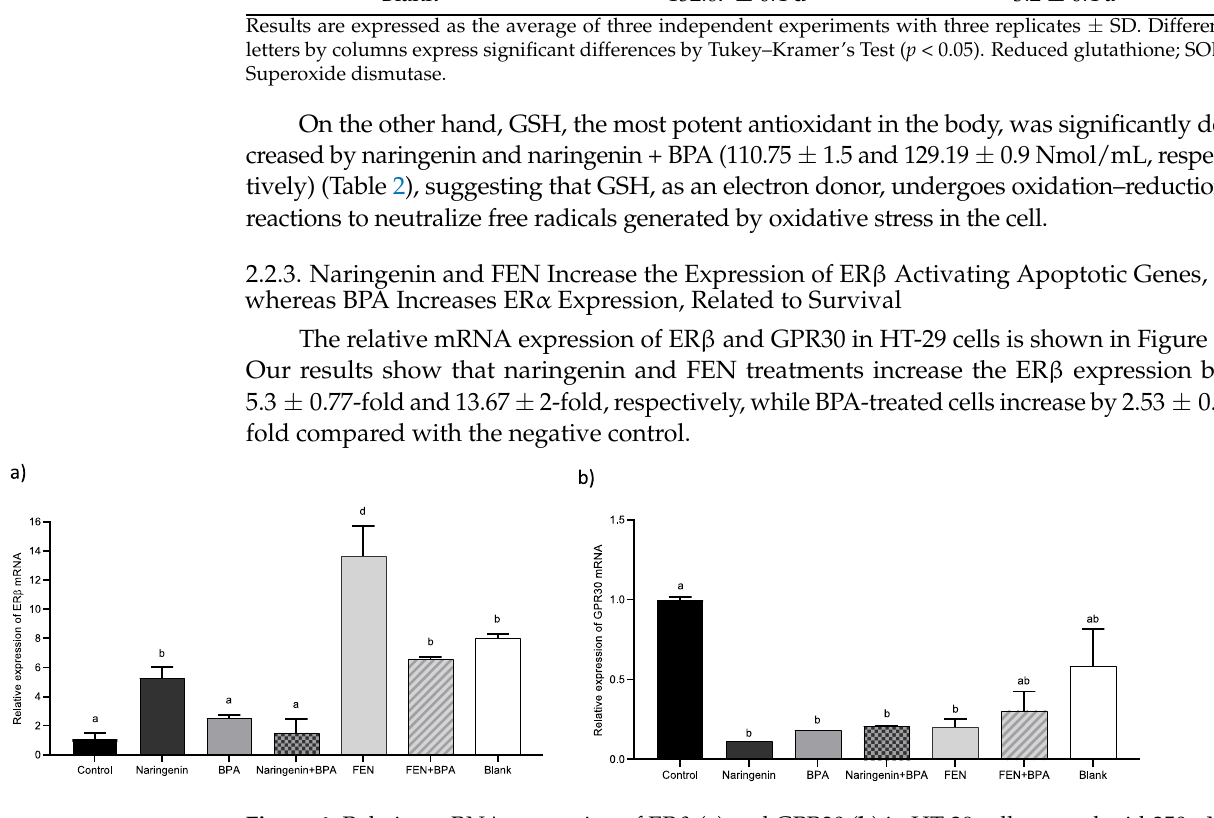
Figure 6. Relative mRNA expression of ER β ( a ) and GPR30 ( b ) in HT-29 cells treated with250 µM naringenin, 4.4 µM BPA, 37% FEN, co-treatment naringenin + BPA or co-treatment FEN + BPA and blank of fermentation (10%). Data expression was normalized with β -actin. The experimental data are expressed as the mean value ± SD of the two independent experiments. Letters indicate statistical difference ( p < 0.05).